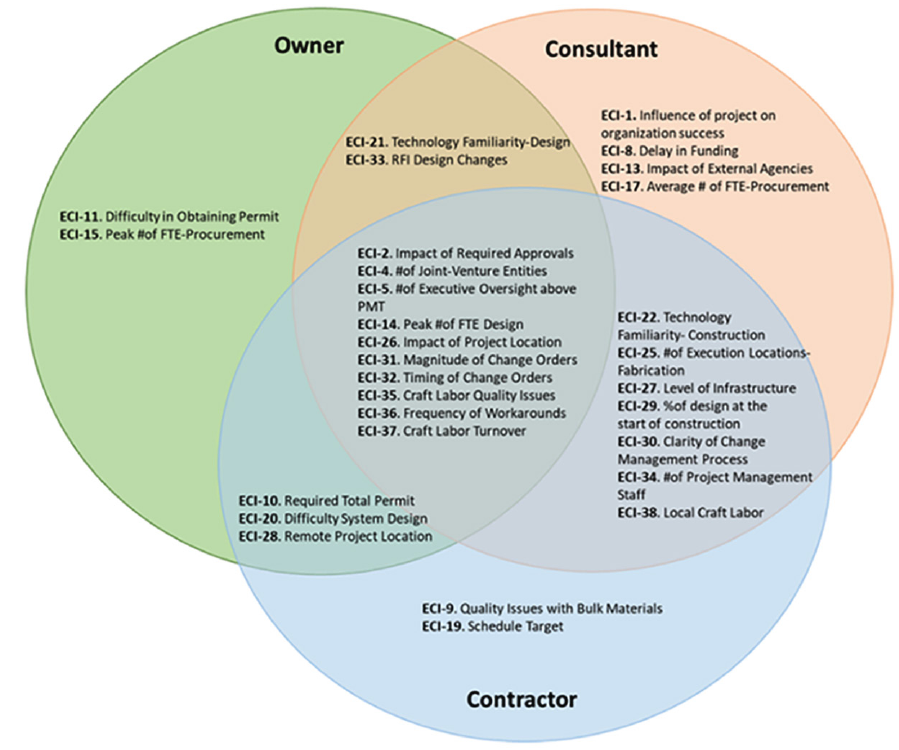
Figure 3. Entity-based complexity indicators and their